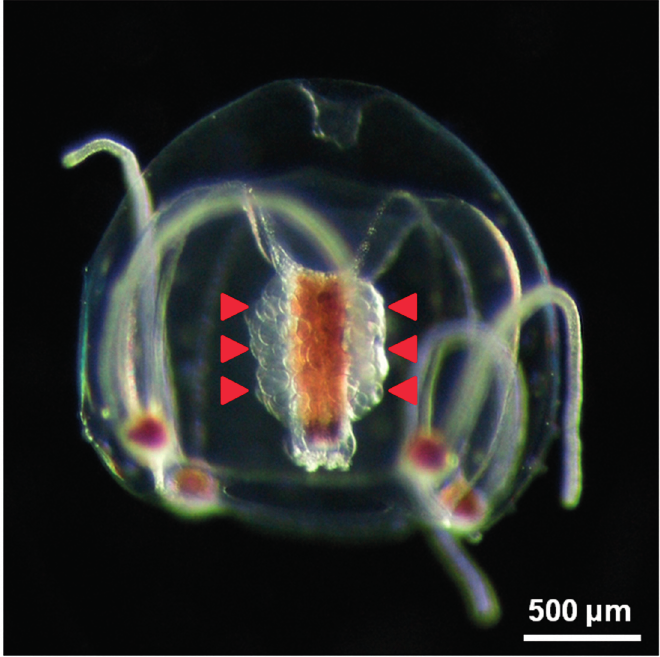
Figure 1. Morphology of an intact female Cytaeis uchidae medusa and released